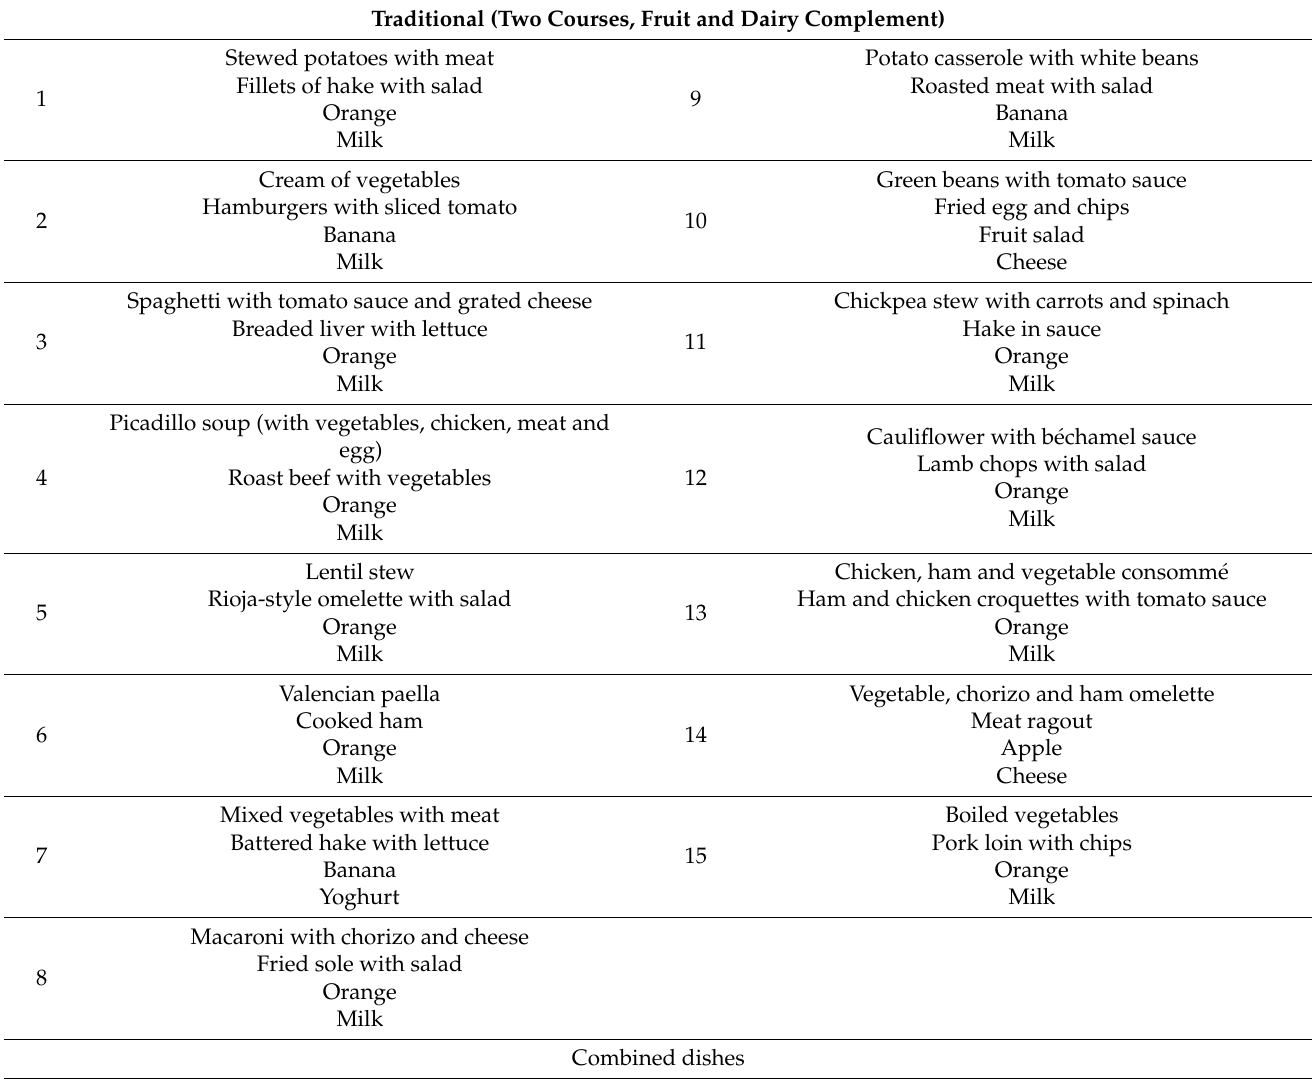
Table 3. Meals (traditional dishes and combined dishes) for school canteens elaborated in 1985. Traditional (Two Courses, Fruit and Dairy